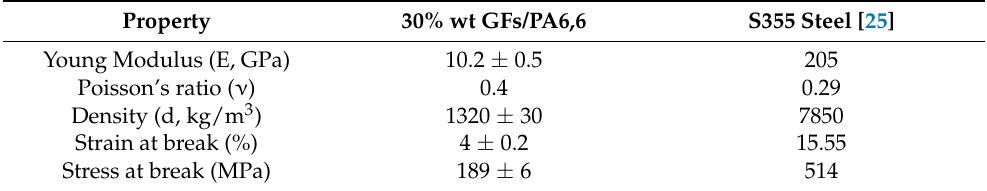
Table 1. Isotropic linear elastic properties of 30% wt GFs/PA6,6 and S355 steel at room temperature.